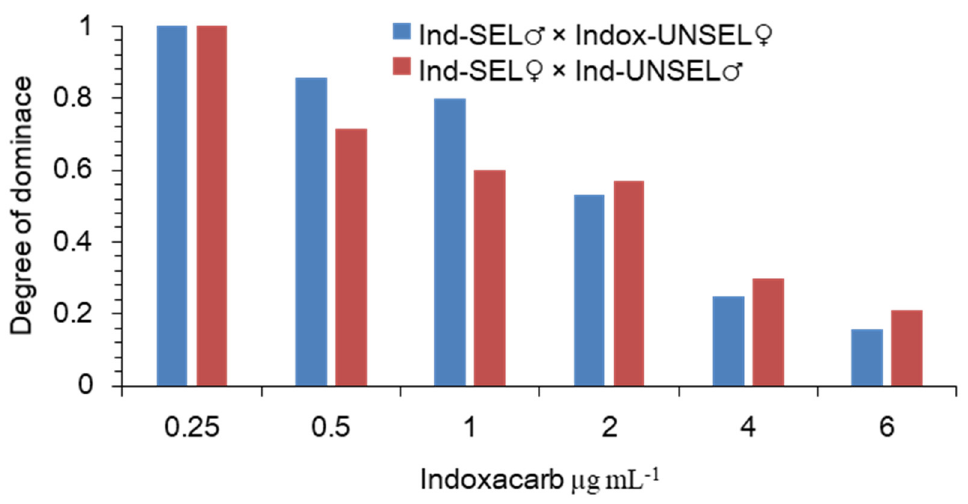
Figure 1. Degree of the dominance of resistance to indoxacarb in S. frugiperda as a function of indoxacarb concentration.